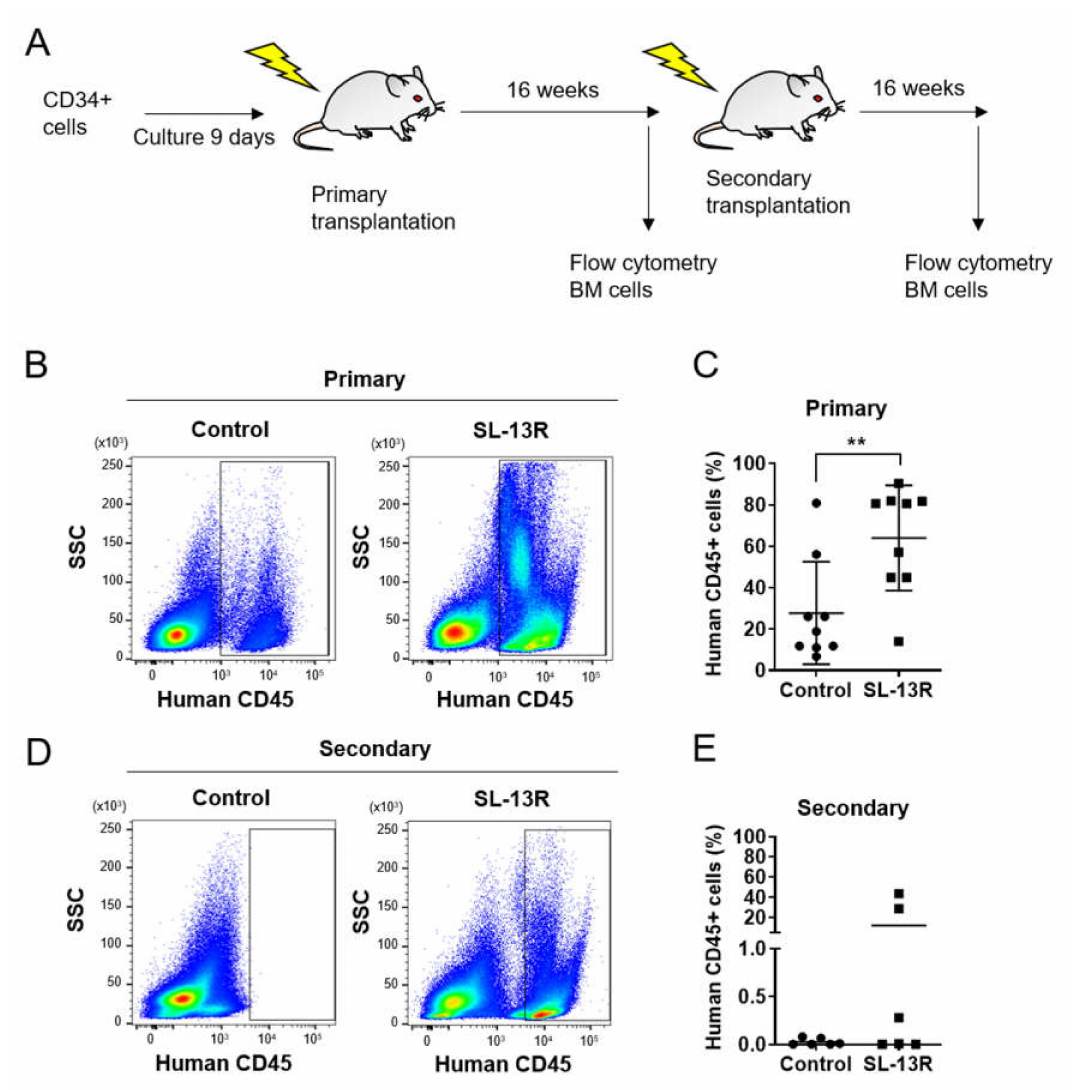
Figure 2. SL-13R-treated UCB CD34+ cells possess long-term reconstitution ability. ( A ) Experimental design of reconstitution assay. NOG mice were irradiated at 2.5 Gy and used as recipients for transplantation. Sixteen weeks after transplantation, bone marrow cells were harvested from 2 femurs and 2 tibias of recipient and expression of human-CD45 was assessed by flow cytometry. ( B ) Representative flow cytometric images of BM MNCs from recipient mice at primary transplantation. ( C ) The percentage of human-CD45+ cells at primary transplantation. n = 9 (9 UCB donors) for both control and SL-13R. ** p < 0.01. ( D ) Representative flow cytometric images of BM MNCs from recipient mice at secondary trans-plantation. ( E ) The percentage of human-CD45+ cells. n = 5 for control (one mouse was dead after trans-plantation), and n = 6 for SL-13R peptide (6 UCB